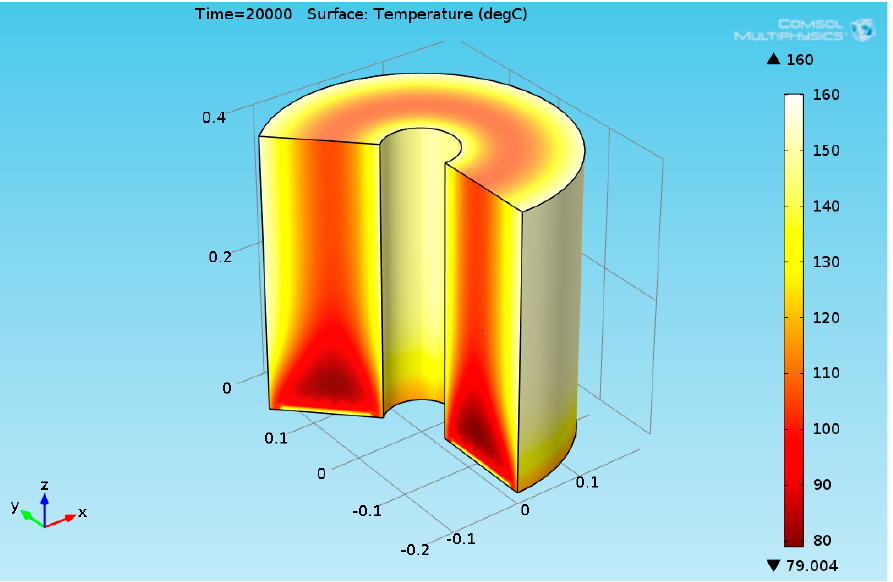
Figure 7. 3D plot of the temperature field inside the esterification reactor at t = 20,000 s.